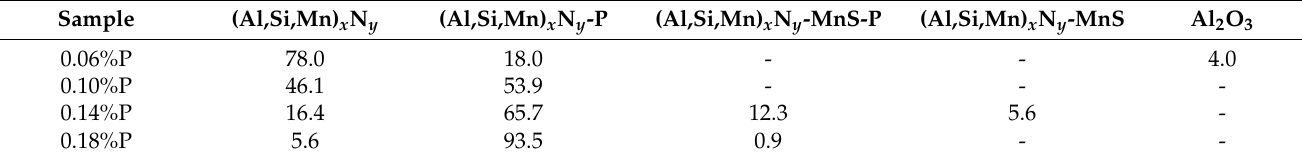
Table 1. Typical composition and percent quantity of major precipitates in the continuously annealed samples, N F